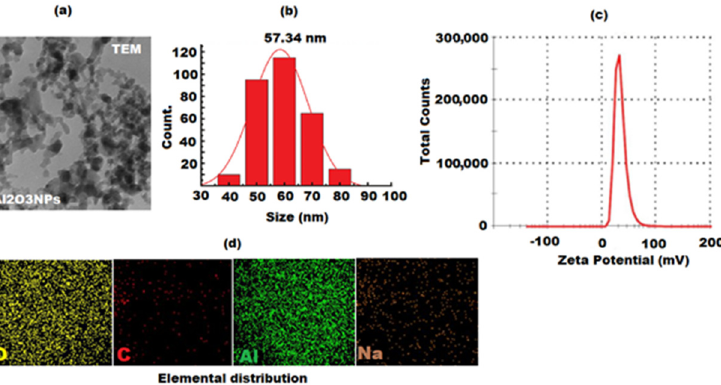
Figure 4. ( a ) TEM, ( b ) particle size distribution, ( c ) DSL analysis, and ( d ) Elemental distribution of oxygen (O), aluminum (Al), carbon (C), and sodium in the EDX mapping of Al 2 O 3 nanoparticles. 3.2. Photocatalytic Efficiency of Al 2 O 3 NPs The photocatalytic degradation performance of biosynthesized Al 2 O 3 NPs was ex- amined under different reaction conditions. The photocatalytic efficacy of nanoparticles depends on surface area, morphology, particle size, crystallinity, bandgap, and OH • free radical content on the photocatalyst surface [68]. The absorption of light causes the re- lease of electron and holes on the photocatalyst surface, and released electrons and holes will participate in the reaction or reunite. If an extra surface is available for the electrons and holes prior to the reunion, they will relocate, and electrons are trapped by the pho- tocatalyst while the holes are activated to generate OH • and HO 2• . The ternary structure